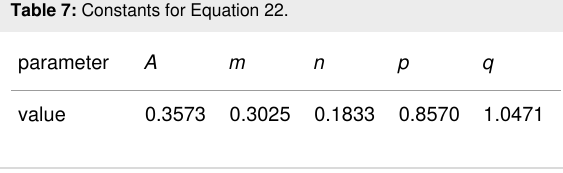
Table 7: Constants for Equation 22.